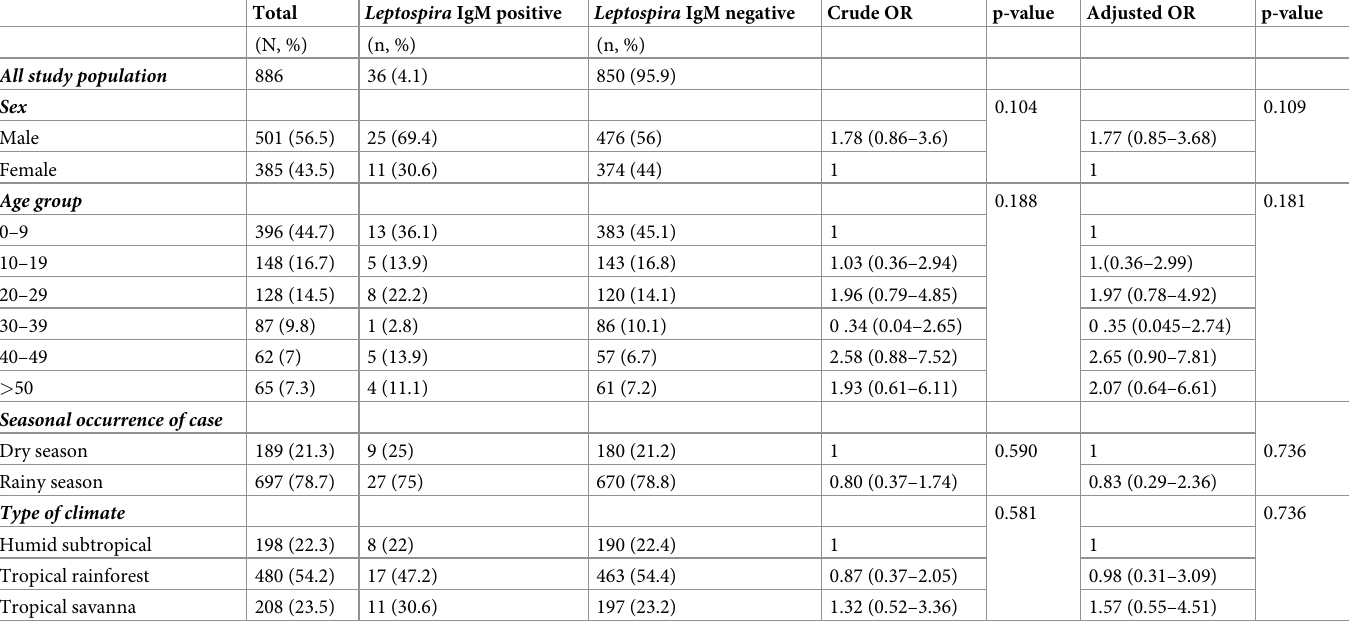
Table 3. Socio-demographic, climate characteristics, and risk factors associated with positive leptospiral serology in rural areas of the DR. Congo